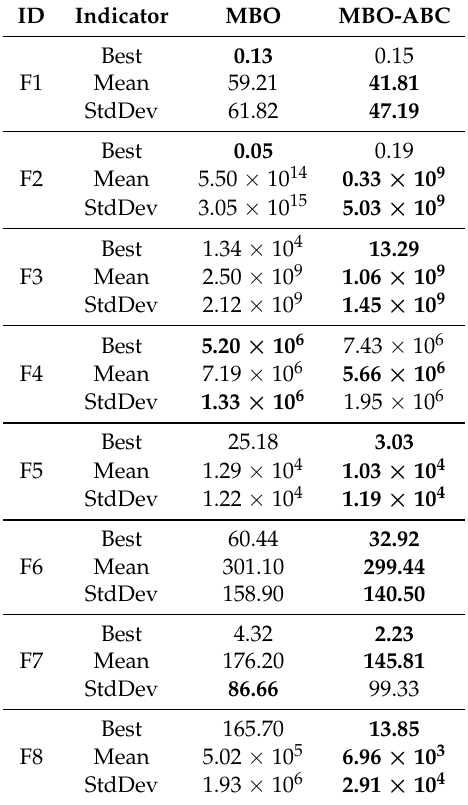
Table 4. Comparative analysis—hybridized MBO-ABC vs. original MBO on benchmarks with dimension D = 60 (bold style is used to indicate better